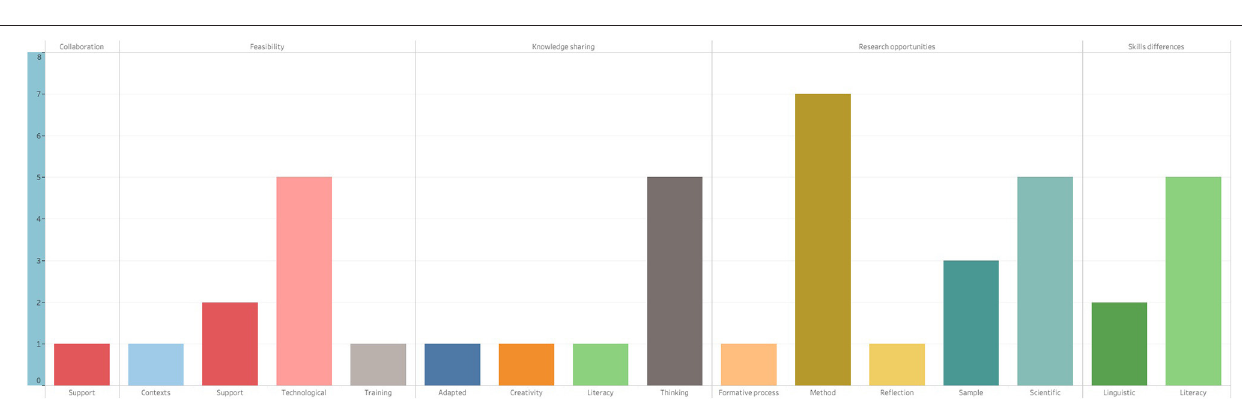
FIGURE 6 | Recommendations for future studies on research skills and processes of academic reading and writing.